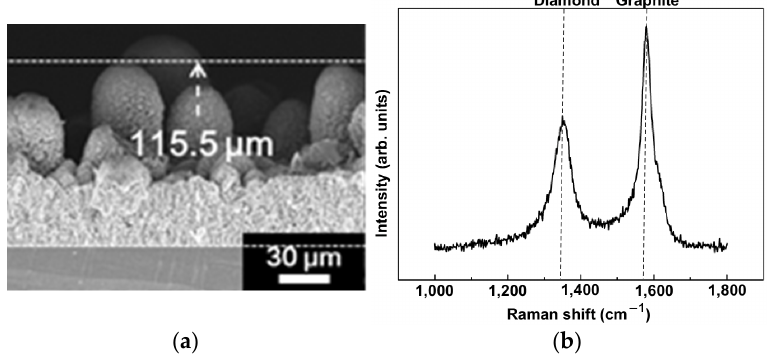
Figure 14. Measurement of ( a ) the film thickness and ( b ) Raman spectroscopy of the diamond film grown on the graphite substrate with working gas containing 32% methane.